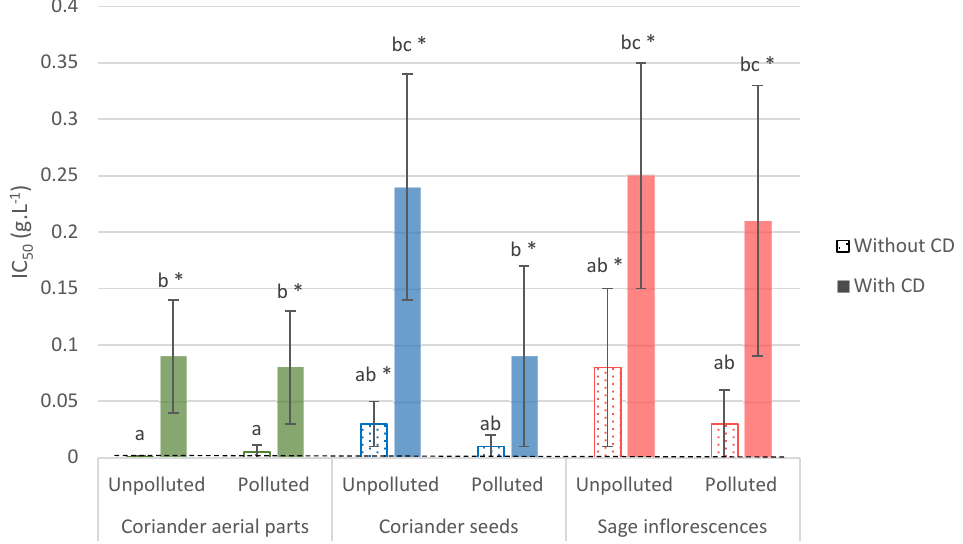
Figure 2. EO’s IC 50 values (g L − 1 ) arising from the antifungal in vitro microplate bioassay against Z. tritici . Values are means ± SD (n = 3). Means followed by the same lowercase letter are not signifi- cantly different, by two-way ANOVA comparison ( α = 0.05). The positive control (Aviator XPro) value is represented by the black dotted line. All conditions different from the positive control are displayed with an asterisk “*”. IC 50 : half-maximum inhibitory concentration; CD: cyclodextrins.